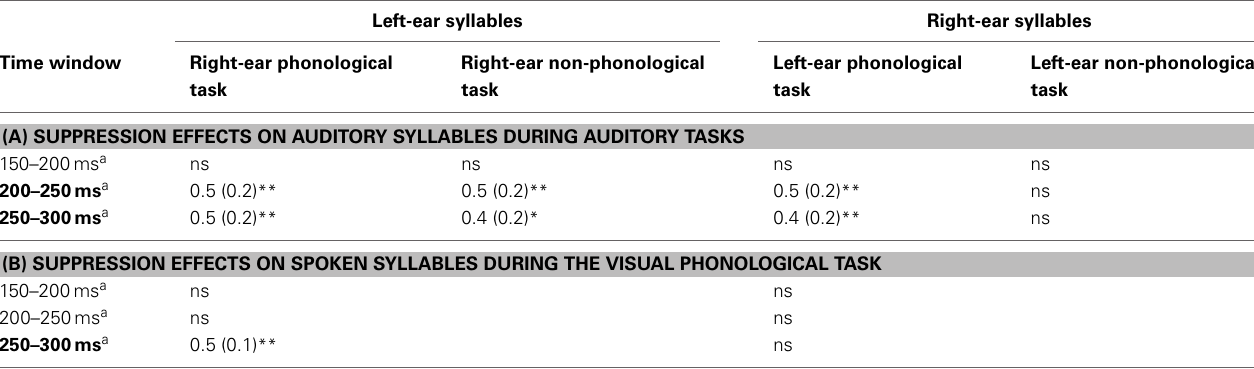
Table 2 | Mean rejection-positivity (RP) amplitudes ( µ V; standard errors of the mean in parentheses) calculated from ERP difference waveforms (see Figure 5) at the Cz